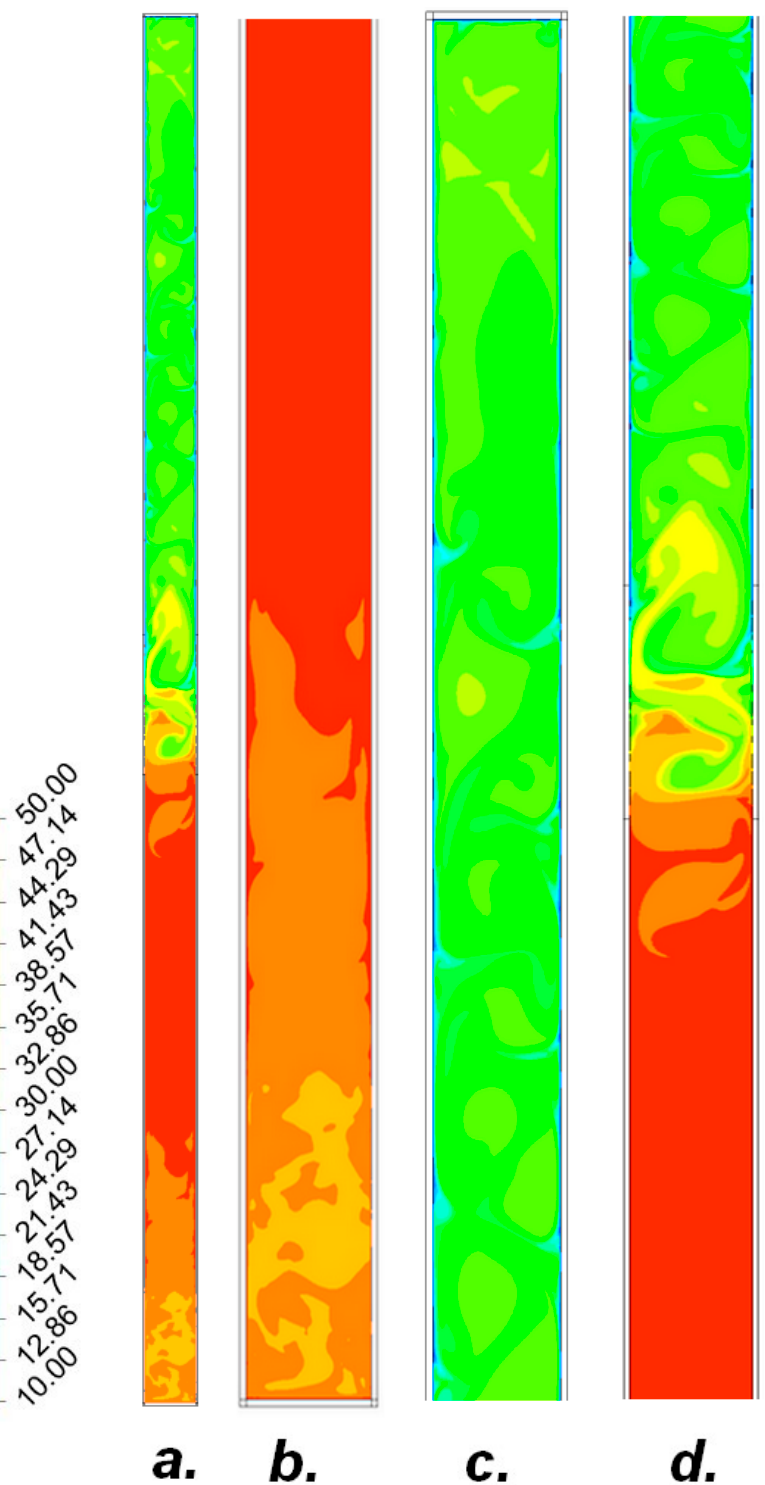
Figure 22. Temperature distribution in the heat pipe. ( a ) Total heat pipe; ( b ) evaporator section; ( c ) condenser section; ( d ) isothermal section.